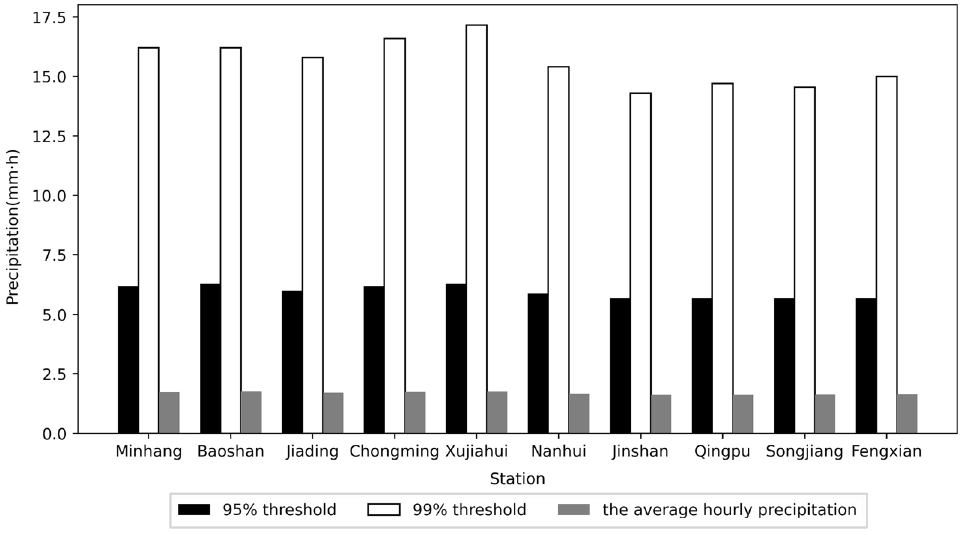
Figure 2. 95% and 99% threshold limit value for each station.